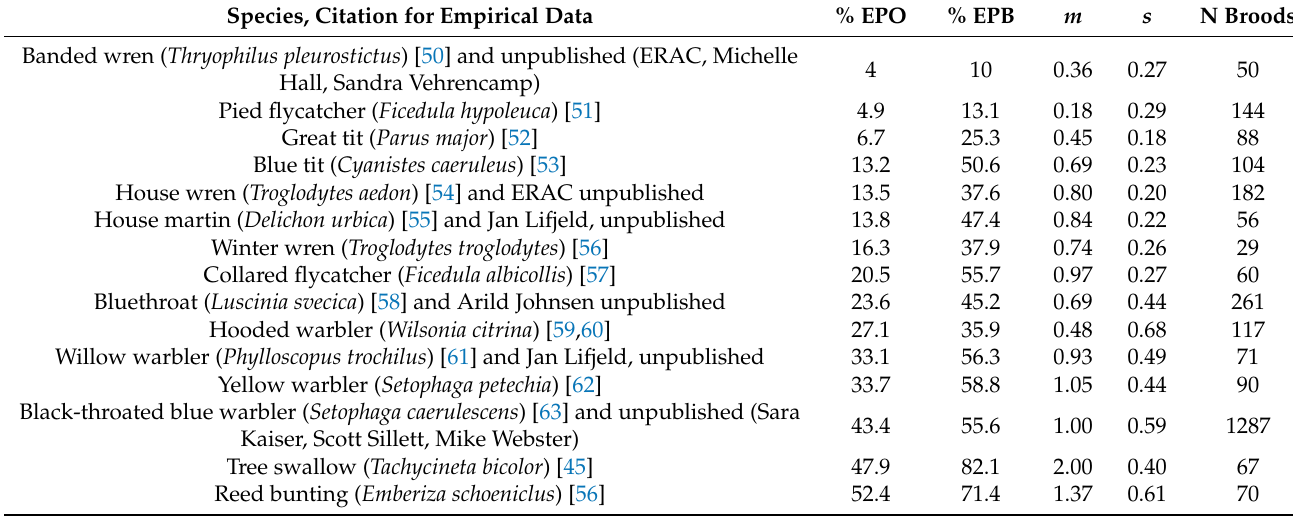
Table 1. Empirical values for extra-pair offspring (EPO) and broods containing at least one EPO (EPB) in the 15 songbird species simulated. Estimated values of parameters used in the simulation represent the average number of extra-pair copulations per female ( m ) and the relative number of extra-pair sperm per copulation ( s